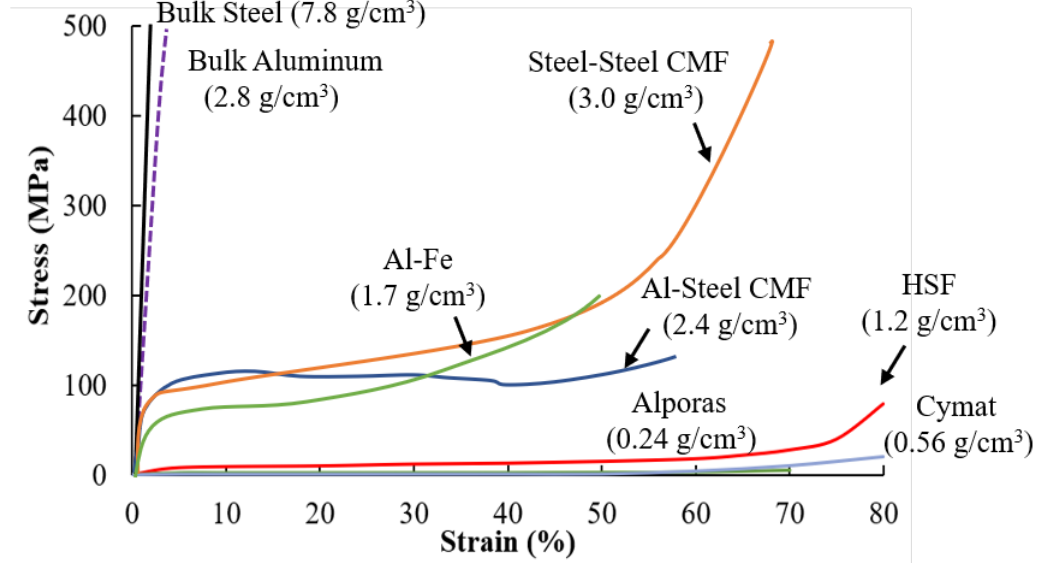
Figure 1. Quasi-static compressive stress–strain curve for steel–steel composite metal foam (SS-CMF) and Al-S CMF compared to bulk aluminum, steel, and other metal foams [25,26,28–32].